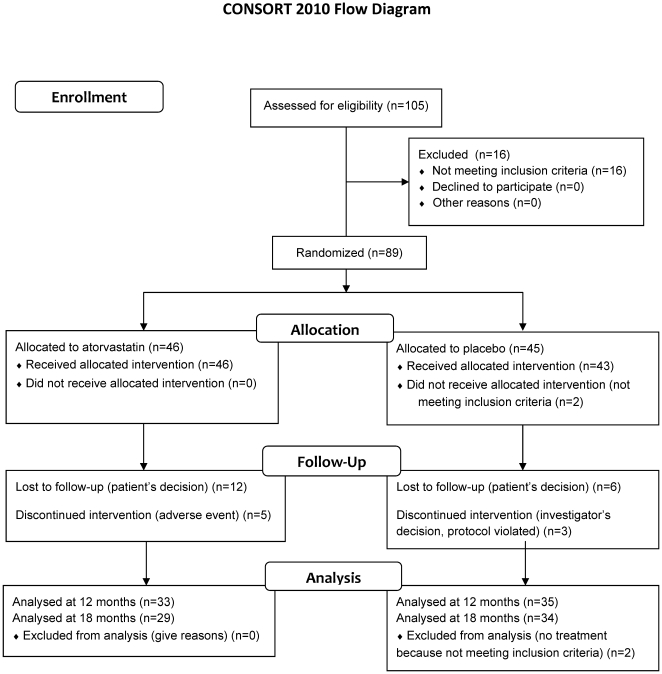
Study flow diagram.Patients were screened in 12 participating centers by using the inclusion and
exclusion criteria.